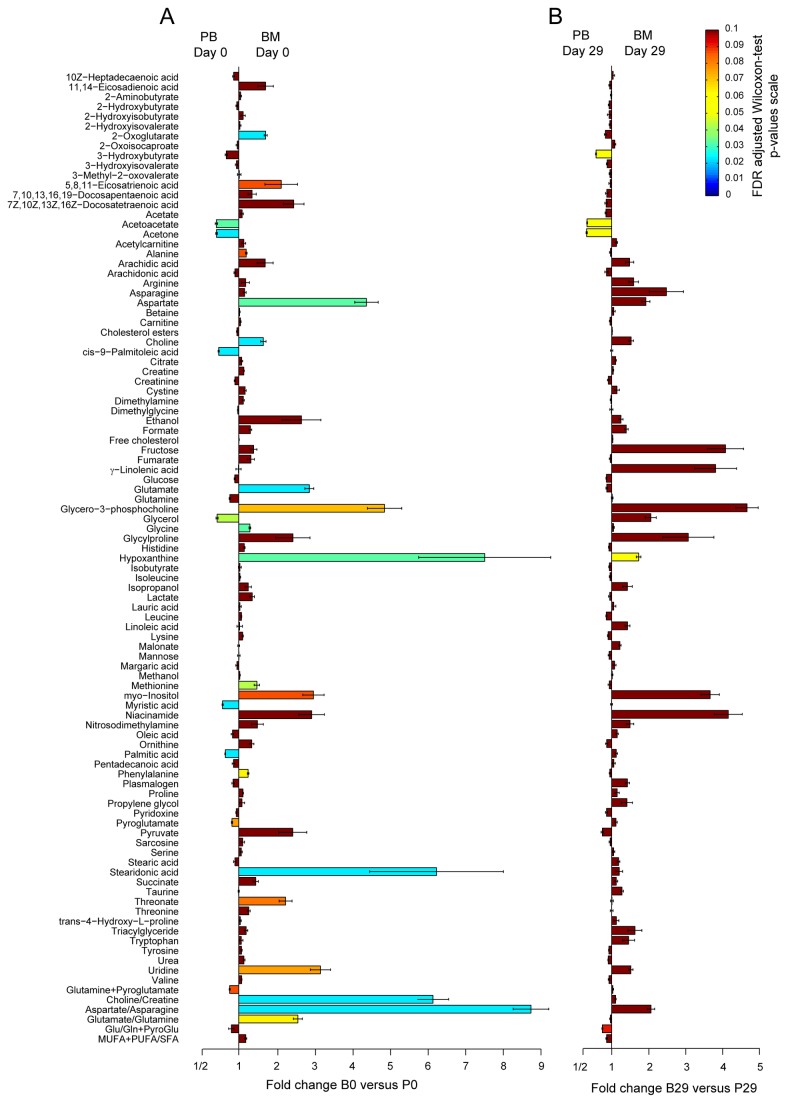
Targeted metabolic analysis of bone marrow and peripheral blood samples at diagnosis and after induction therapy.Shown are the mean fold differences in metabolite concentrations in BM and PB samples collected (A) at the time of diagnosis and (B) after induction therapy (mean ± SEM, n = 10 patients). Statistical significance was assessed based on absolute metabolite concentrations (SI, Table S1) using the nonparametric two-sided Wilcoxon Rank Sum Test (WRST) and p-values were corrected using false discovery rate (FDR). The bar plot is color coded according to p-values (pFDR < 10%). At day 0 (A), 22 metabolites were significantly different between BM and PB with pFDR <10%, 14 of which had pFDR <5%. In contrast, only 4 of 110 identified metabolites were found to be significantly different between BM and PB at day 29 (B). Both bar plots also show the differences in the ratios of glutamate to glutamine, aspartate to asparagine, choline to creatine, unsaturated to saturated fatty acids, and the sum of glutamine plus pyroglutamate.